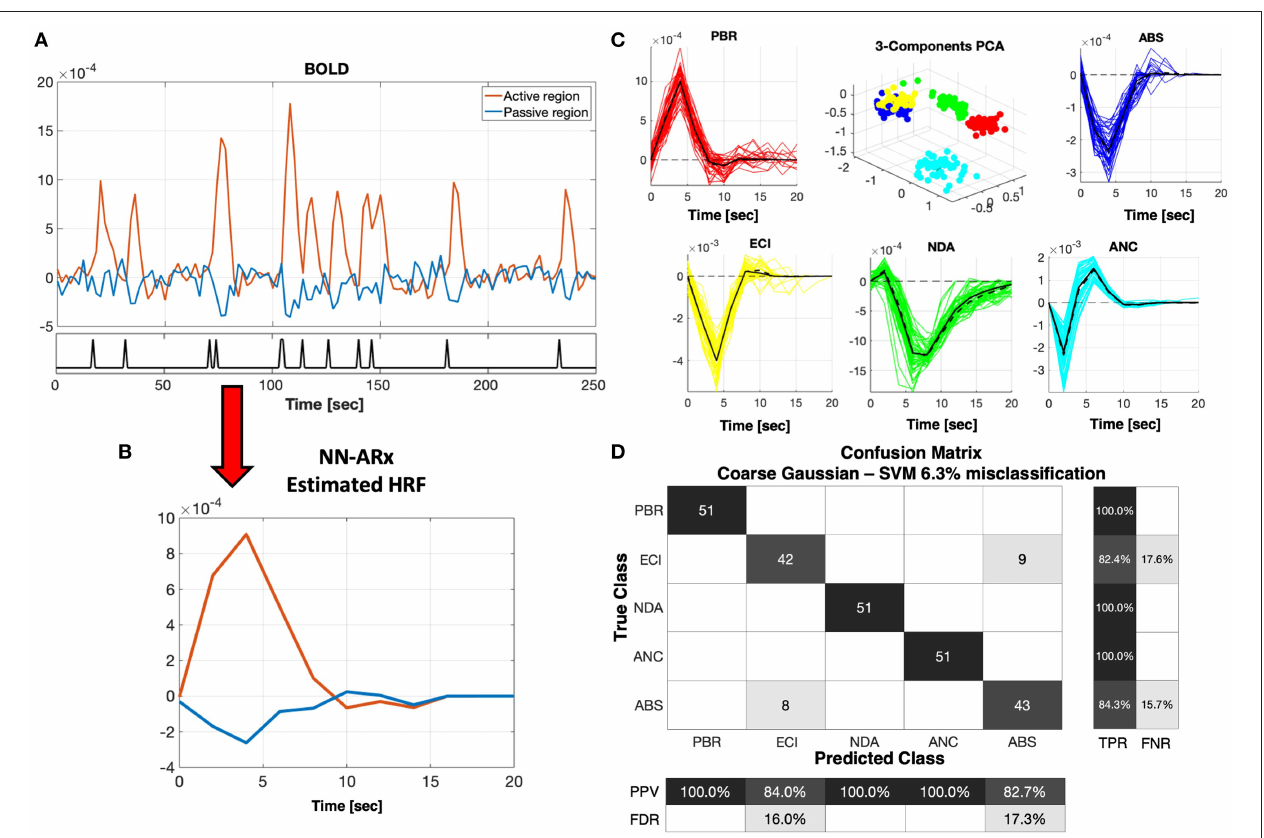
FIGURE 3 | NN-ARx estimation and classification of HRFs. (A) Example of a portion of simulated fMRI time series for the ABS mechanism. The input u ( t ) is represented with a black trace at the bottom graph. (B) Both positive and negative HRFs estimated using NN-ARx from the example in A. (C) Estimated HRFs from all trials. The black continuous curve represents the average across trials, whereas the black dash curve corresponds to a simulation without noise. To geometrically illustrate their separability, the 3D plot depicts the scores of the first three components of the PCA decomposition of the matrix formed by stacking all HRF as row vectors, after normalizing their amplitudes. PBR (red), ECI (yellow), NDA (green), ANC (cyan), and ABS (blue). (D) Results of the five-fold cross-validation of the SVM classifier with a coarse Gaussian kernel function resulted in 6.3% of misclassification. Center figure shows the confusion matrix. TPR, true-positive rate; FNR, false-negative rate; PPV, positive predictive value; FDR, false discovery rate. As expected, the PBR is distinguishable from all the NBRs. NDA and ANC mechanisms were also perfectly classified, whereas ECI and ABS are the ones that are closer to each